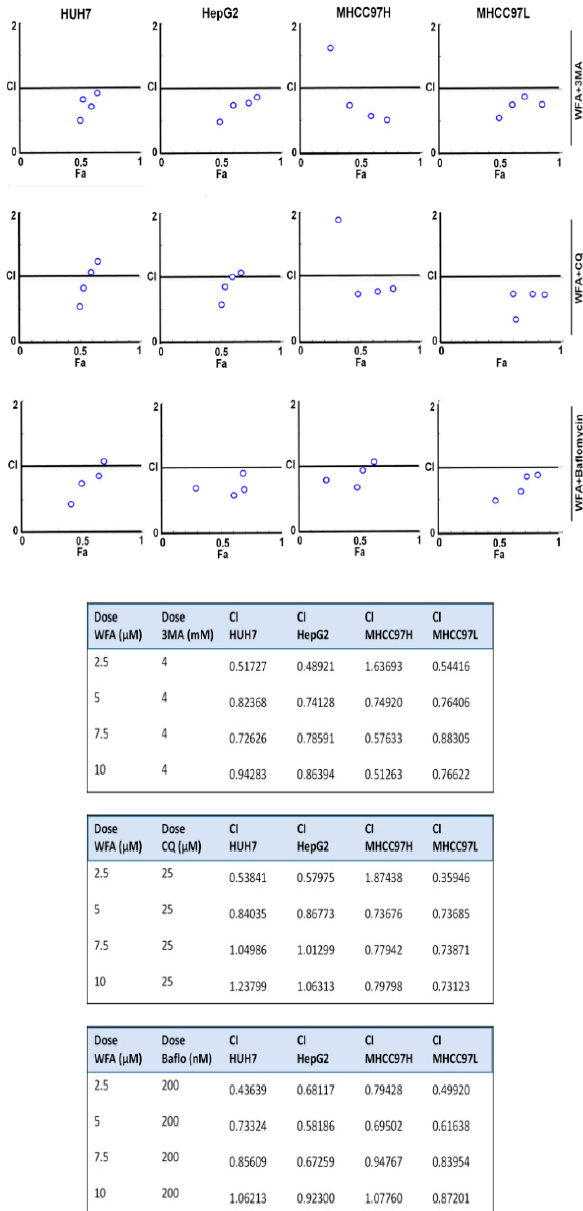
Figure 7. Synergistic interaction between Withaferin A and autophagic inhibitors. Inhibitory effects of WFA combined with 3MA, Chloroquine (CQ) and bafilomycin, respectively, in various HCC cells. The CI value was calculated using the Chou-Talalay method. CI < 1, CI = 1 and CI > 1 indicates synergistic, additive and antagonistic effects, respectively.